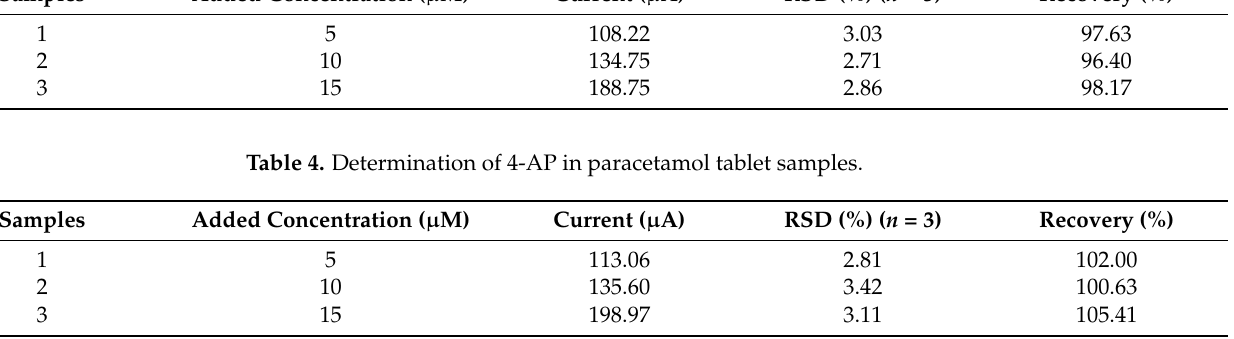
Figure S5: (a) SWV in water samples and (b) in Paracetamol